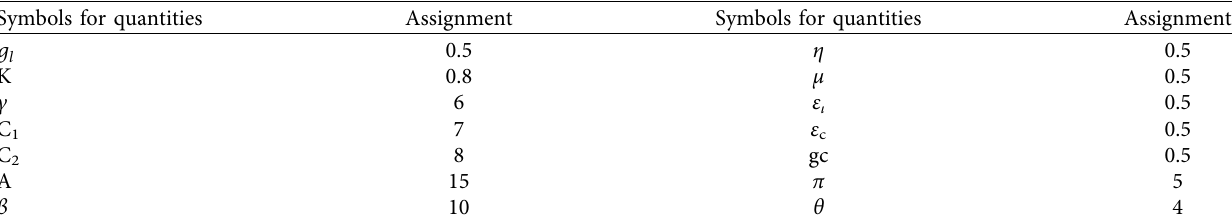
Symbols for quantities